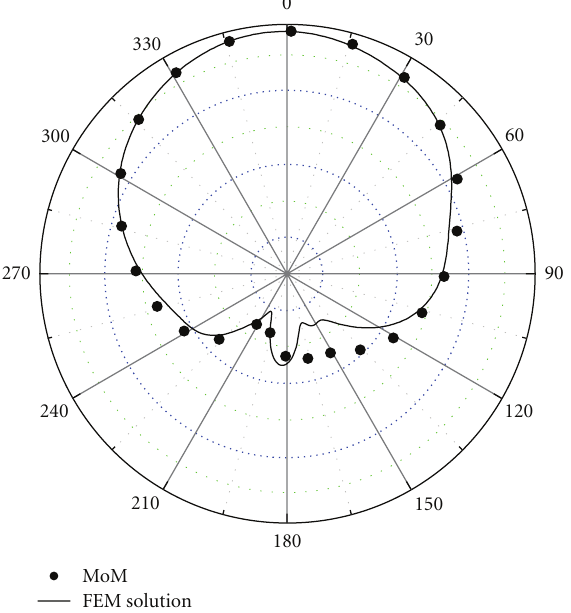
Figure 4: E-plane radiation pattern of microstrip antenna at f = 7 . 5GHz.